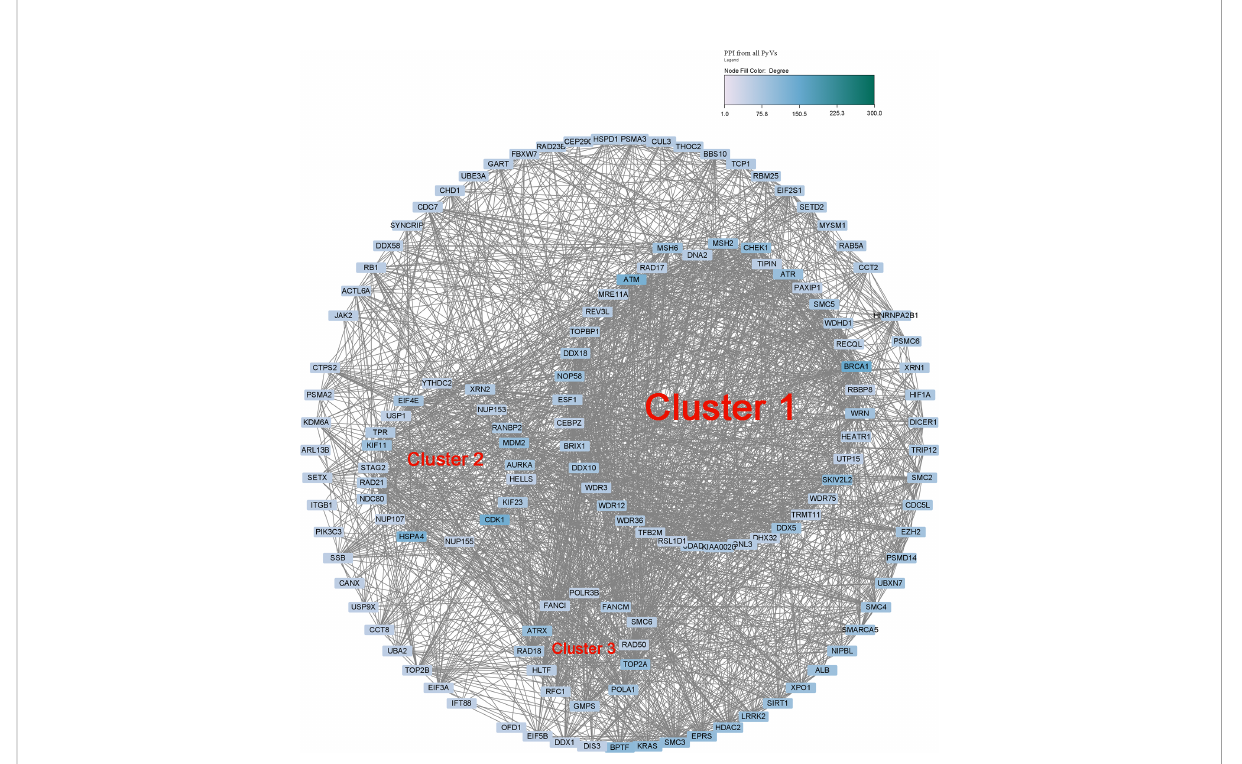
FIGURE 4 Protein-protein interaction network of human genes with CUB similar to that of HPyVs.